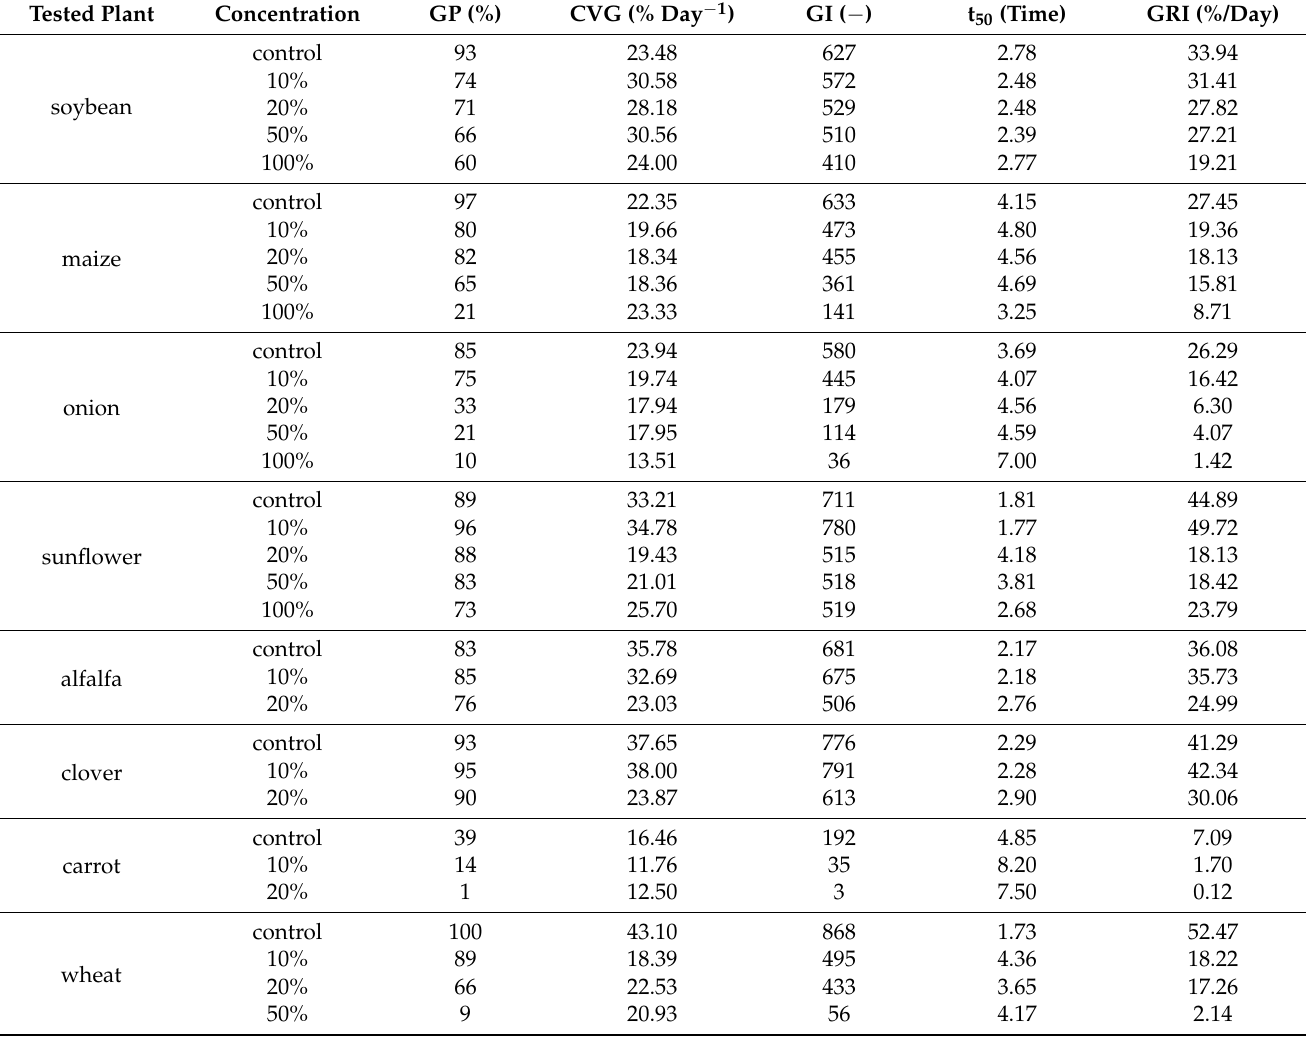
Table 1. The obtained results for the calculated germination indices in the case of the tested cultivated species treated with T . vulgaris hydrolate solutions.